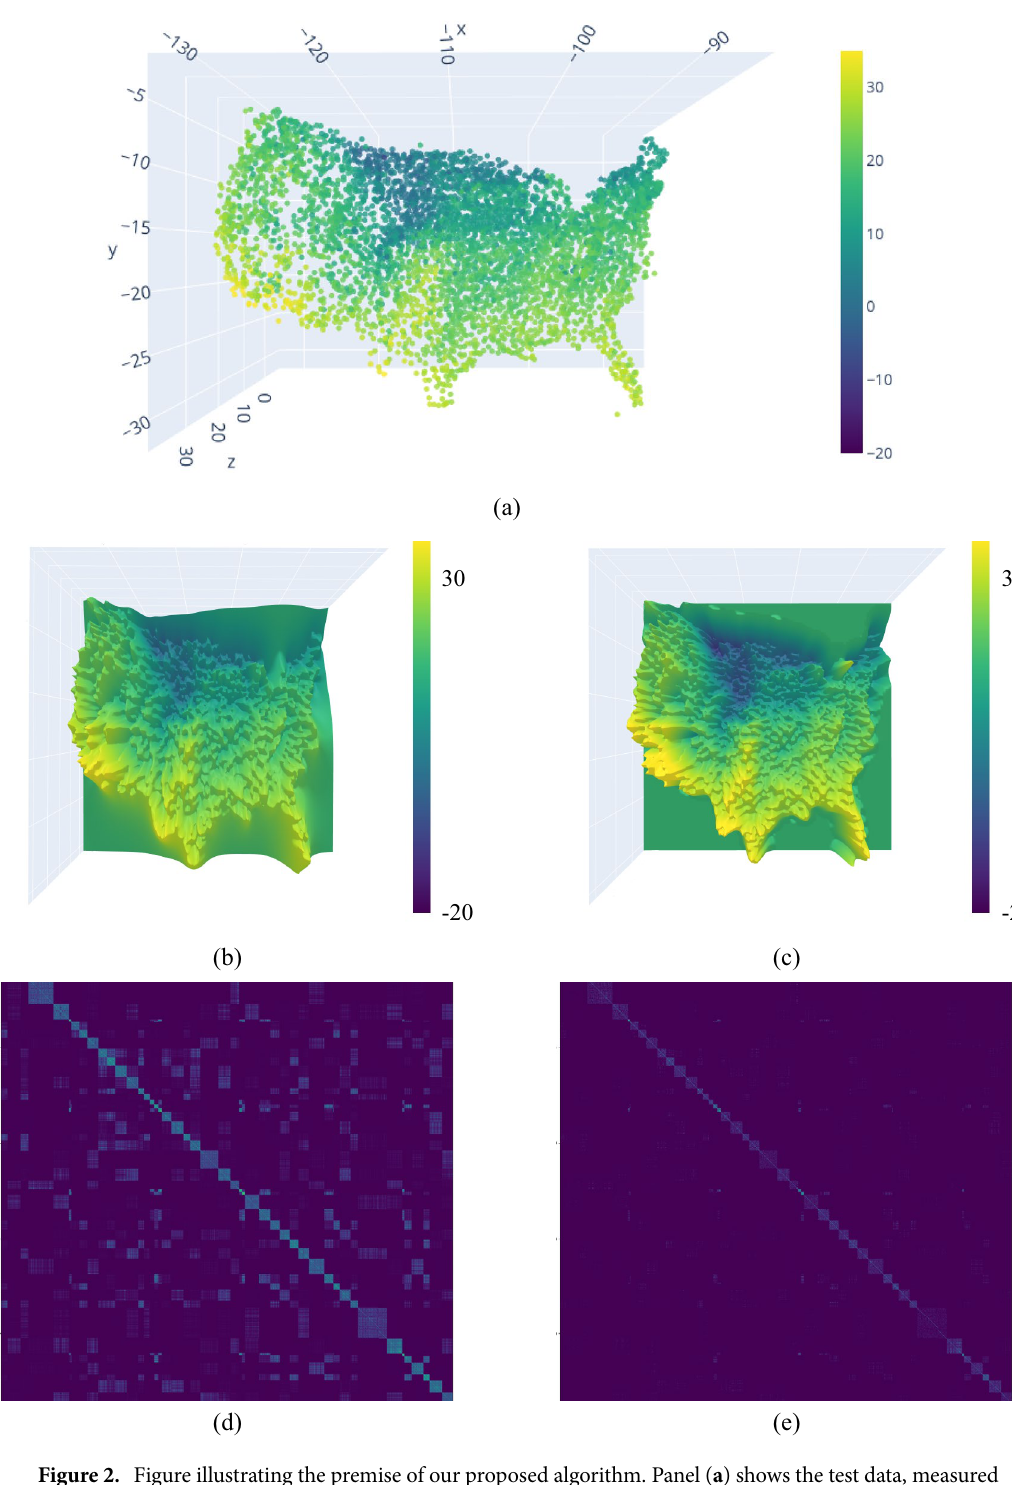
4718 ). This problem =